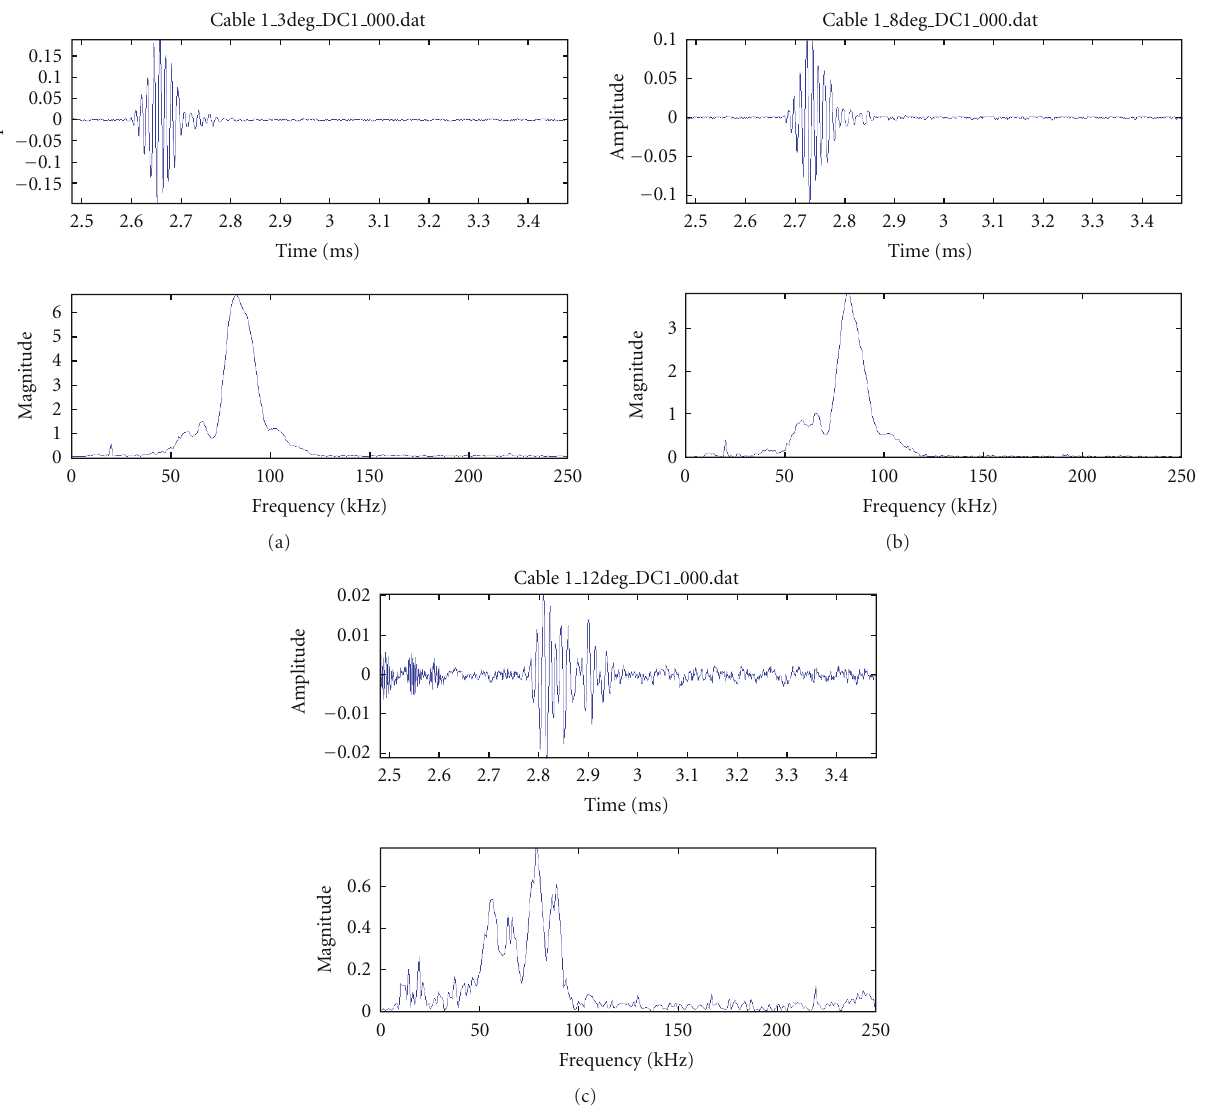
Figure 16: Signals and spectra for type C cable using test pulse DC1: (a) 3 ◦ aspect response similar to broadside; (b) 8 ◦ aspect return much reduced but still distinctive; (c) 12 ◦ aspect, detection good but at lower SNR reverberation a ff ects spectral